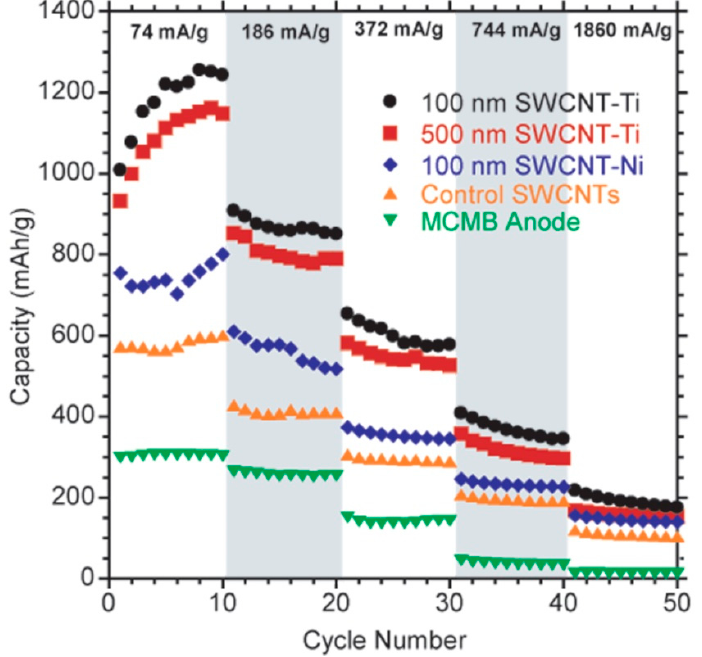
Figure 7. Rate cycle performance of various electrodes: single-walled nanotubes (SWCNT) (orange), SWCNT composite with Ni (blue), SWCNT composite with Ti (100 nm nanotube size—black; 500 nm—red), and standard graphite mesocarbon microbead (MCMB) (green). Reprinted with permission from [92]. Copyright 2010 American Chemical Society.